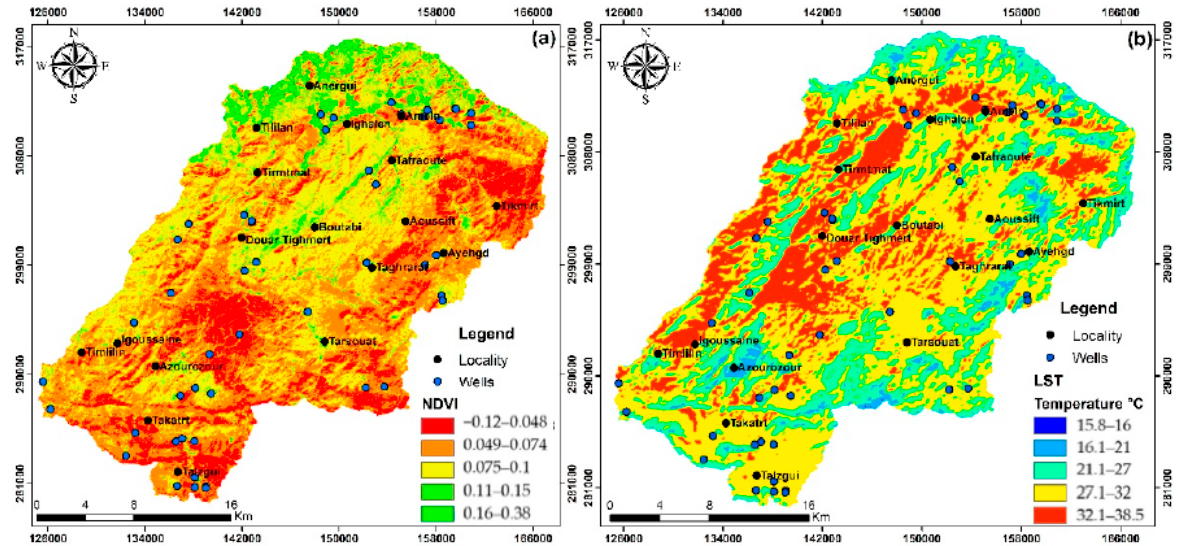
Figure 12. Climatological factors influencing groundwater. ( a ) Normalized difference vegetation index (NDVI); ( b ) Land surface temperature.